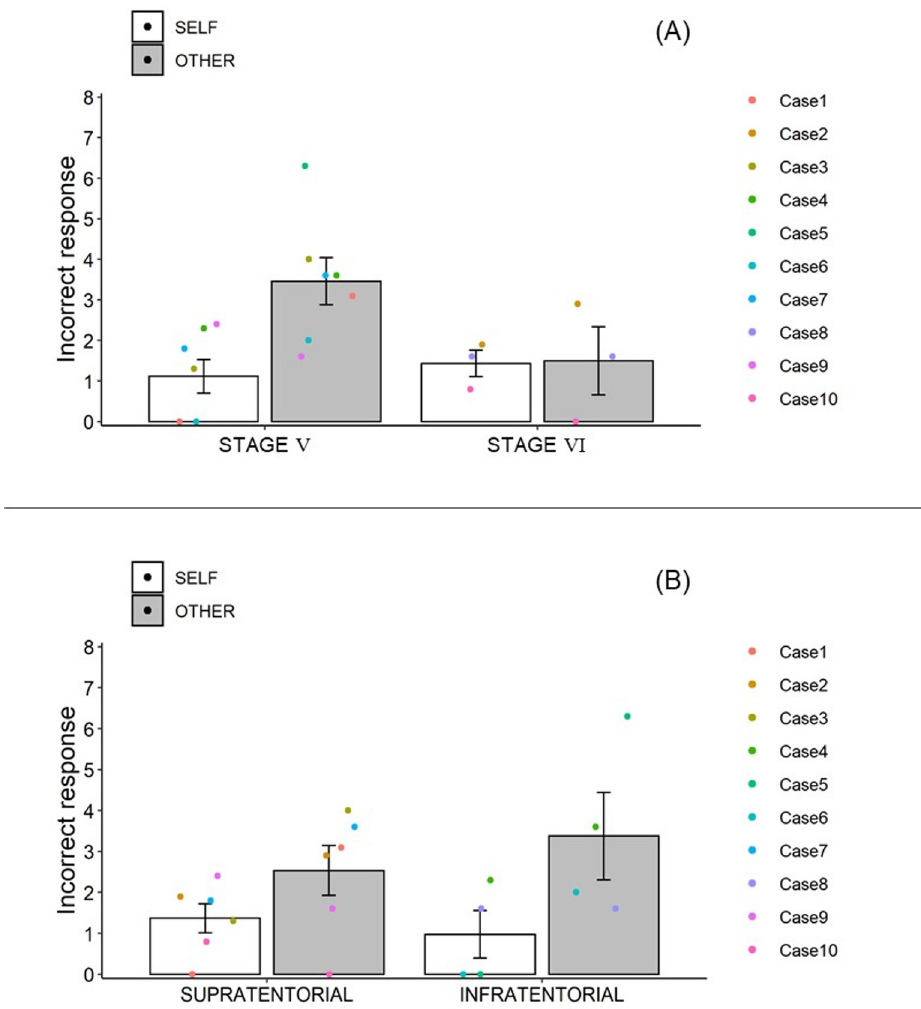
Fig 5. Incorrect responses (i.e., misattributions) on the self-other judgments between post-stroke patients with Brunnstrom stage 5 and 6 (A) and between post-stoke patients with supratentorial and infratentorial lesions (B). Error bars indicate standard